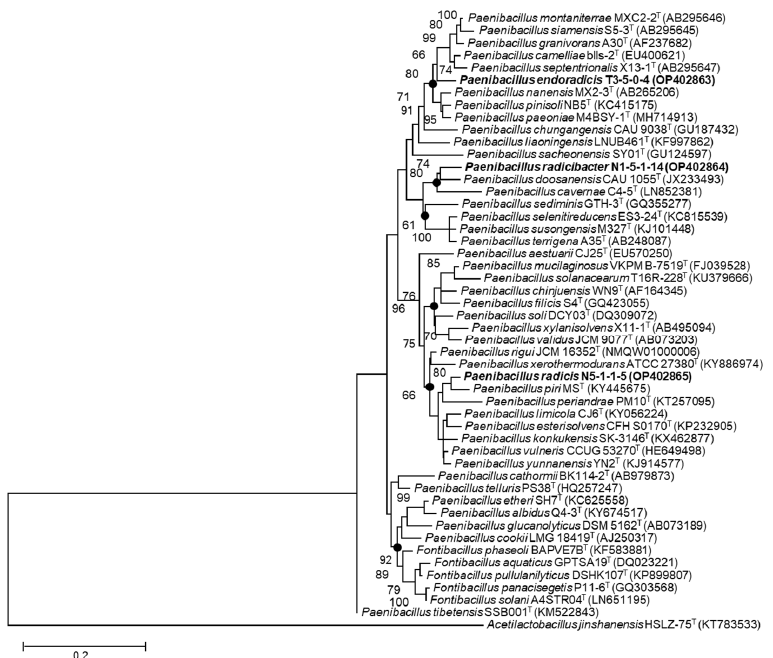
Figure 1. Maximum likelihood tree illustrating the phylogenetic position of T3-5-0-4, N1-5-1-14 and N5-1-1-5 and other type species in the genus Paenibacillus based on 16S rRNA gene sequences. The sequence of Acetilactobacillus jinshanensis HSLZ-75 T was used as the out-group. Closed circles indicate branches that were recovered with all three tree-making methods (maximum-likelihood, maximum-parsimony, and neighbor-joining). Bootstrap values (expressed as percentages of 1000 replications) over 60% are shown at branching nodes. Bar, 0.2 substitutions per nucleotide position.